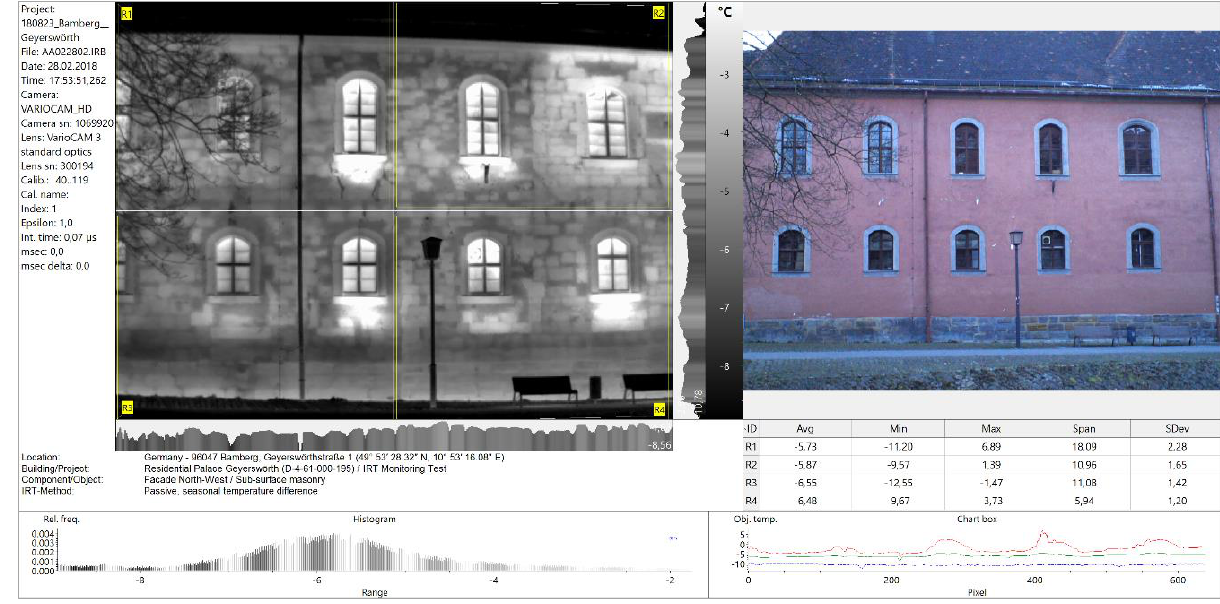
Figure 1: Greyscale visualisation of radiometric information, depicting thermal distribution, variations and anomalies in temperature